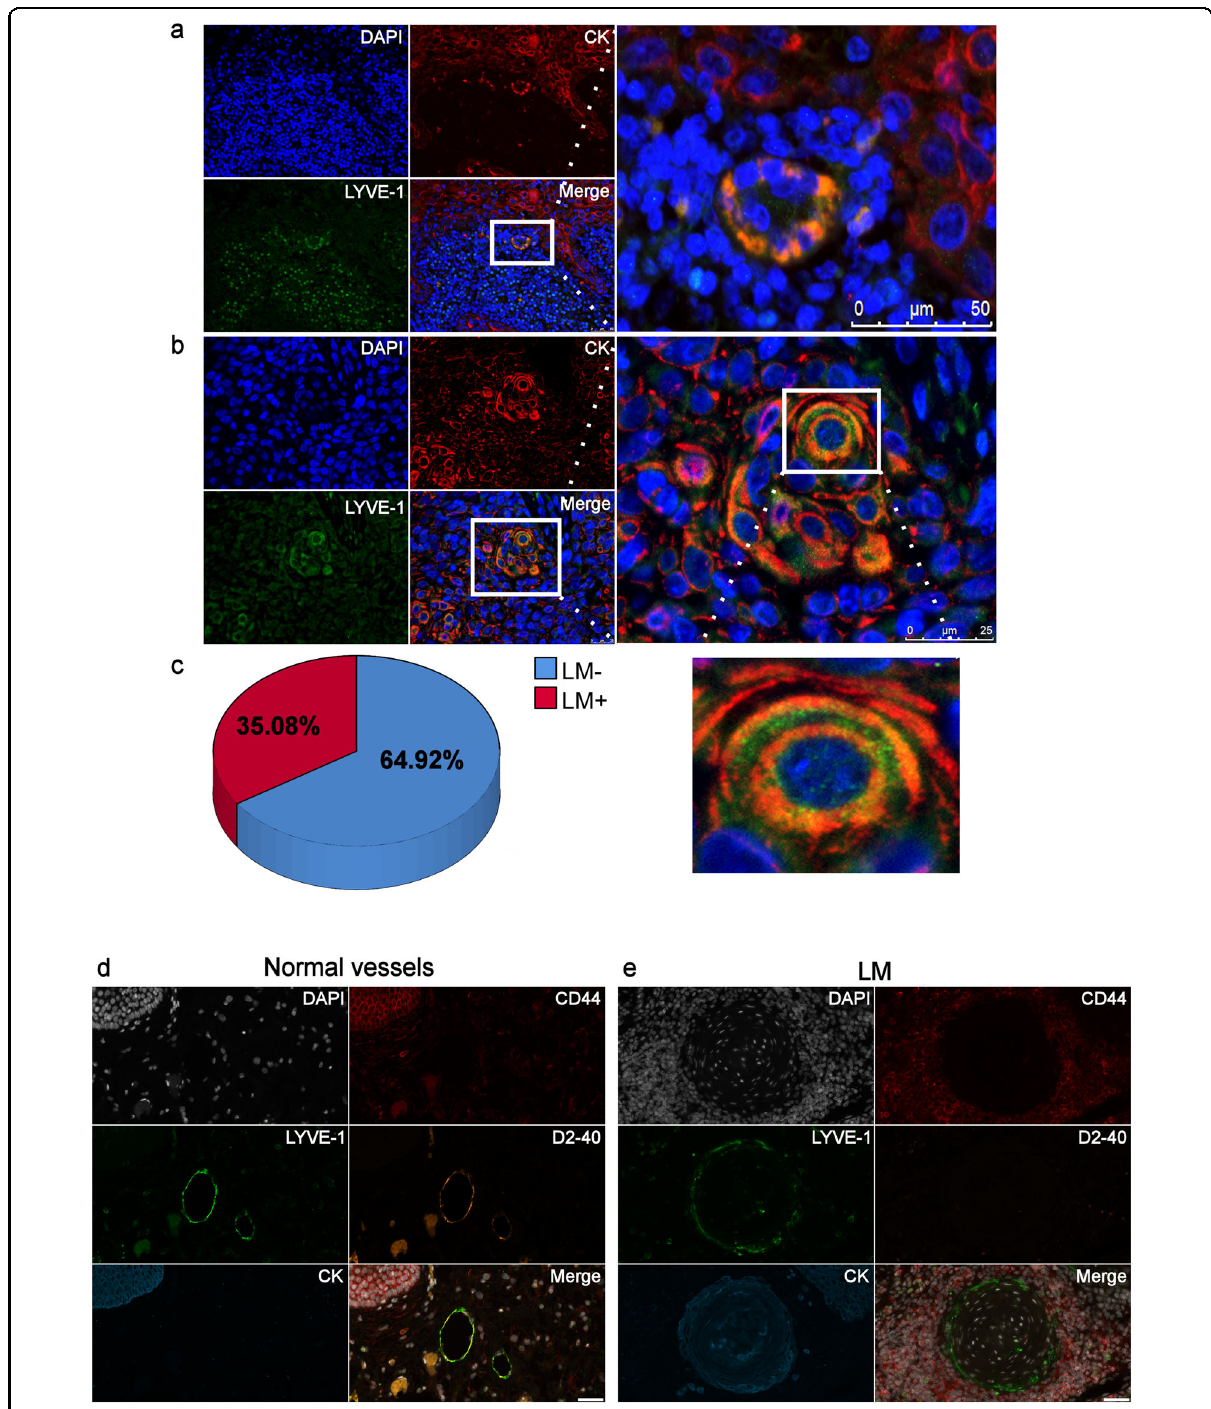
Fig. 1 (See legend on next